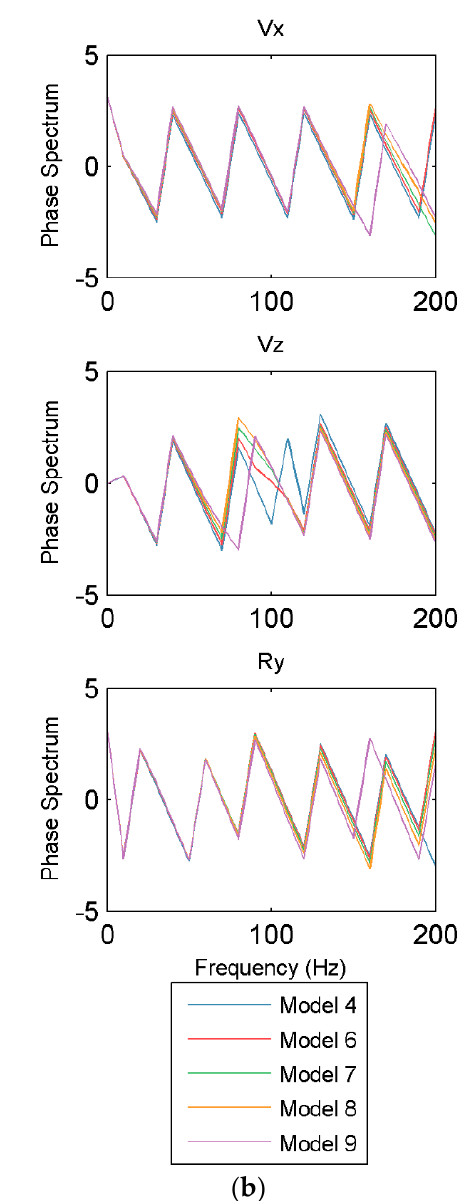
Figure 11. Influence of anisotropy parameters on phase spectra of the 90th trace generated from the expansion source: ( a ) when ε varies; ( b ) when δ varies.